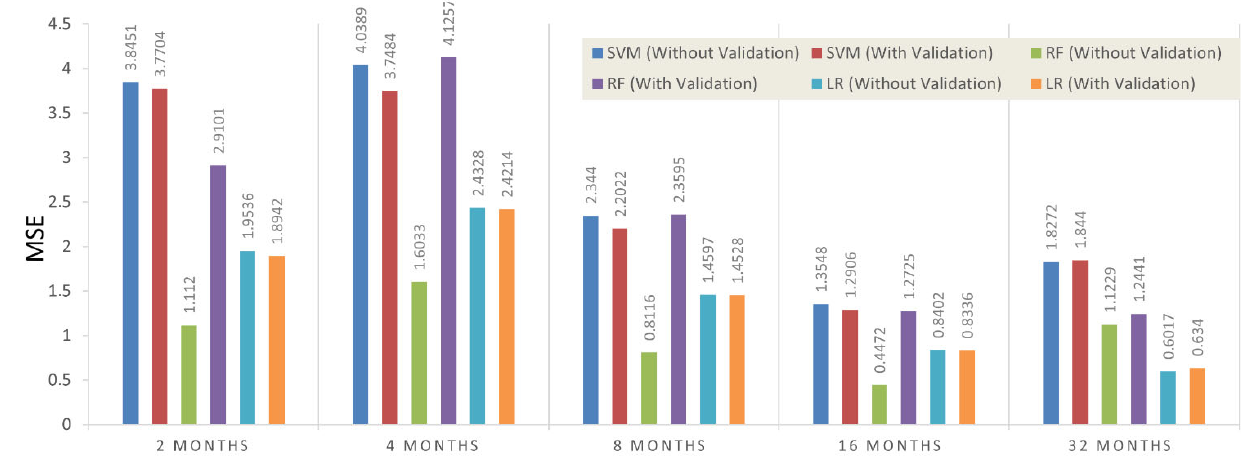
Figure 10. Graphic of MSE results.